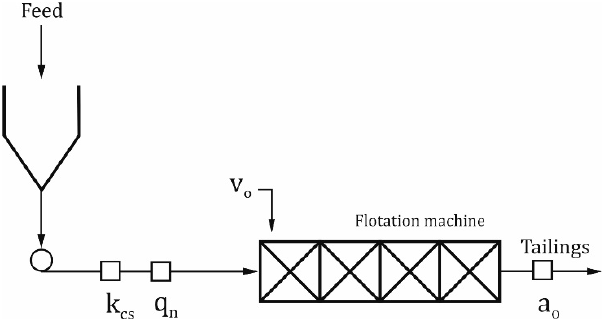
Figure 5. Industrial facility for the coal flotation